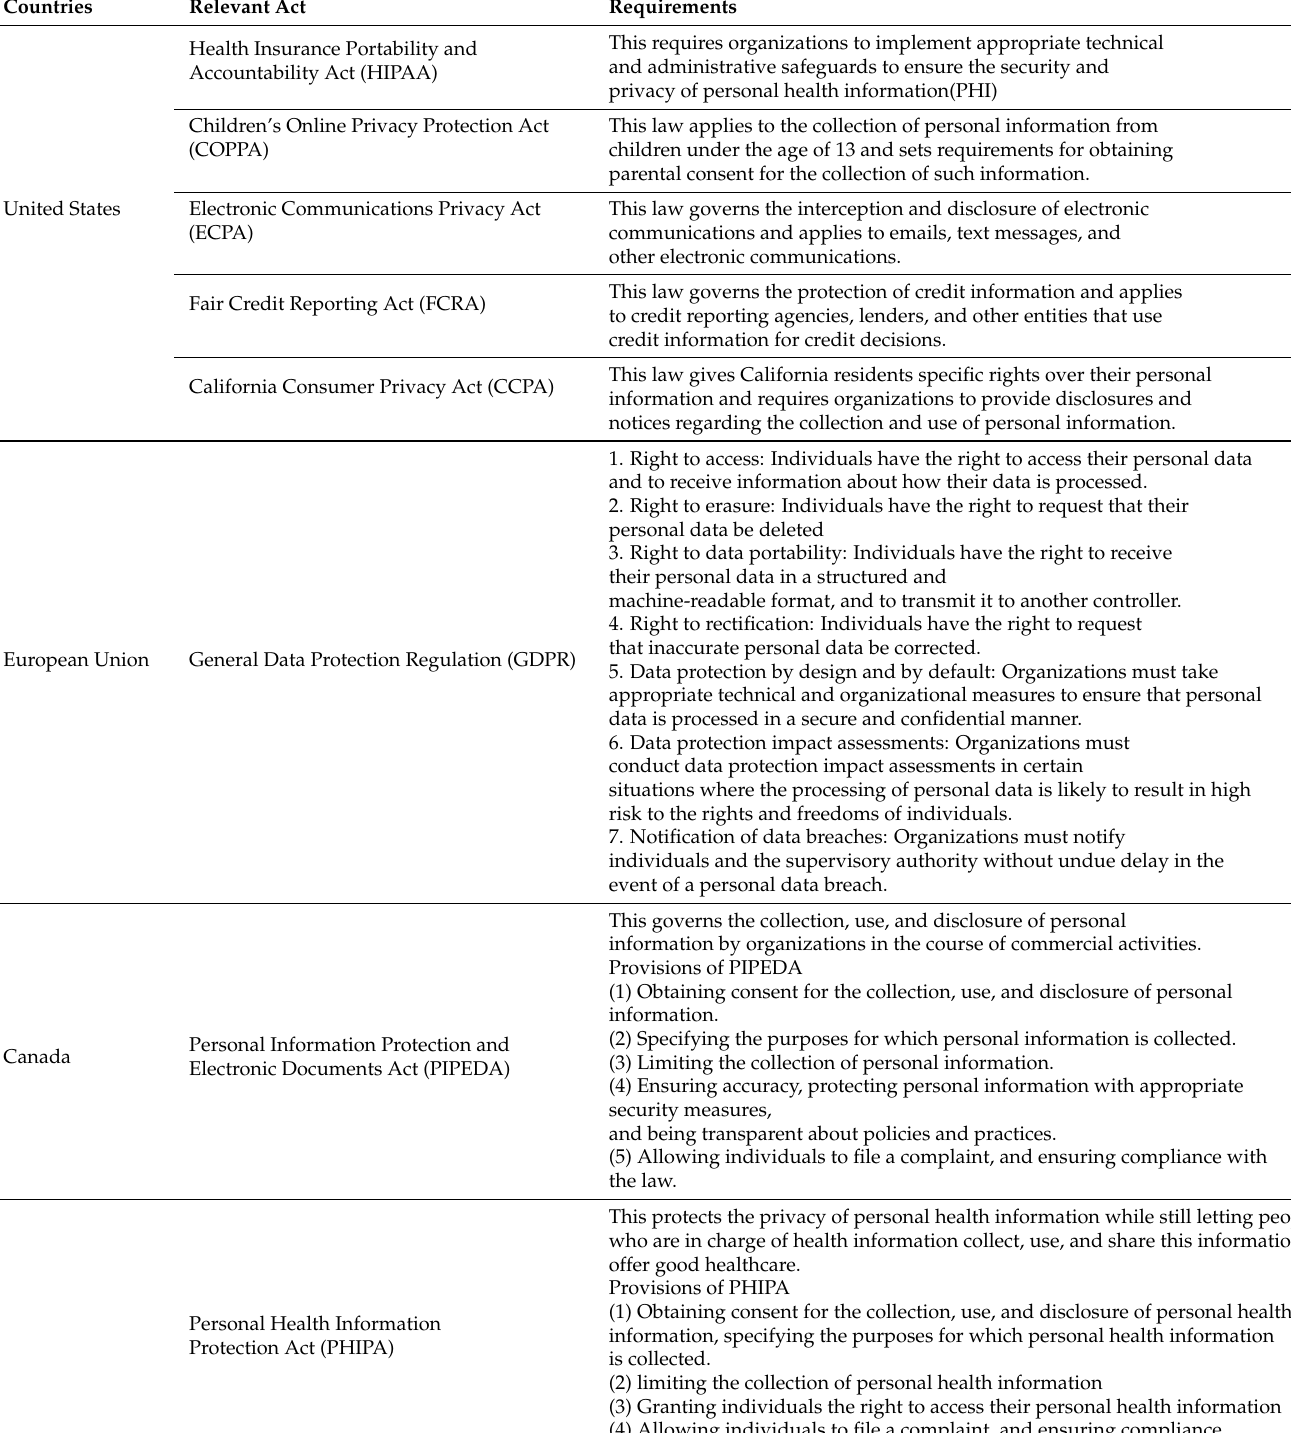
Table 2. Data Protection Laws in Different